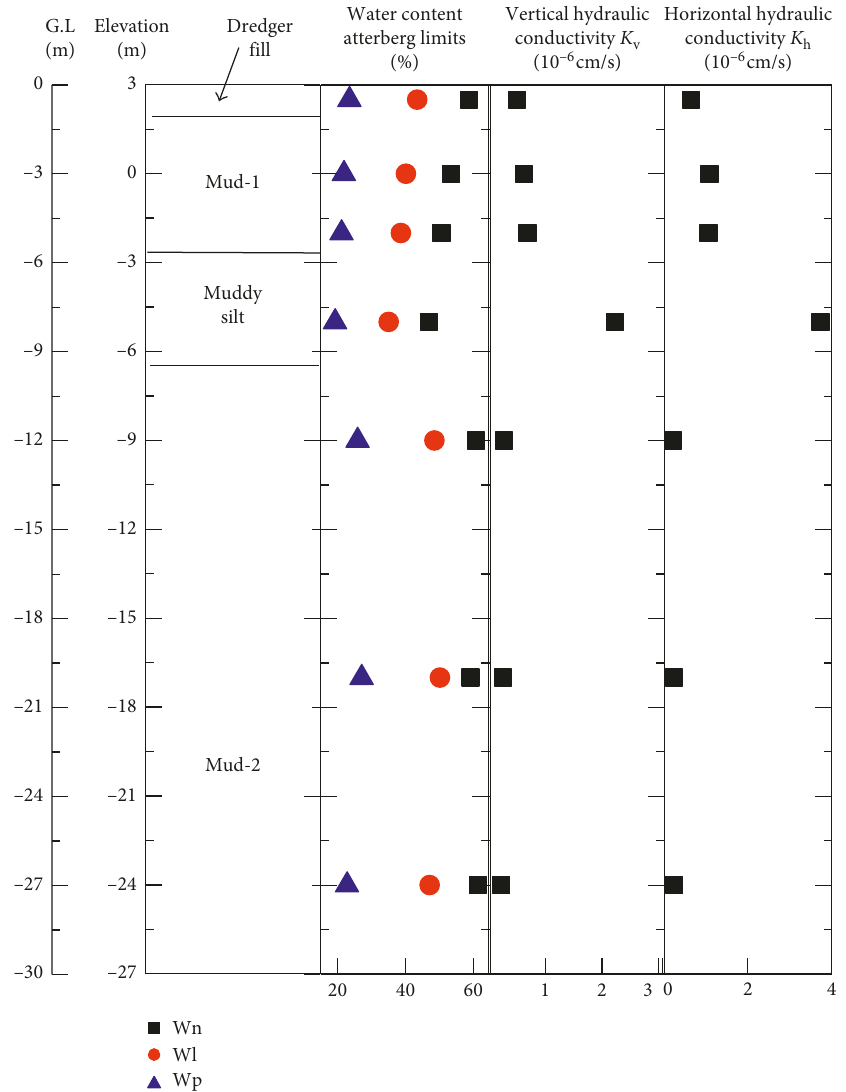
Figure 3: Soil profile and some physical properties at the test site.